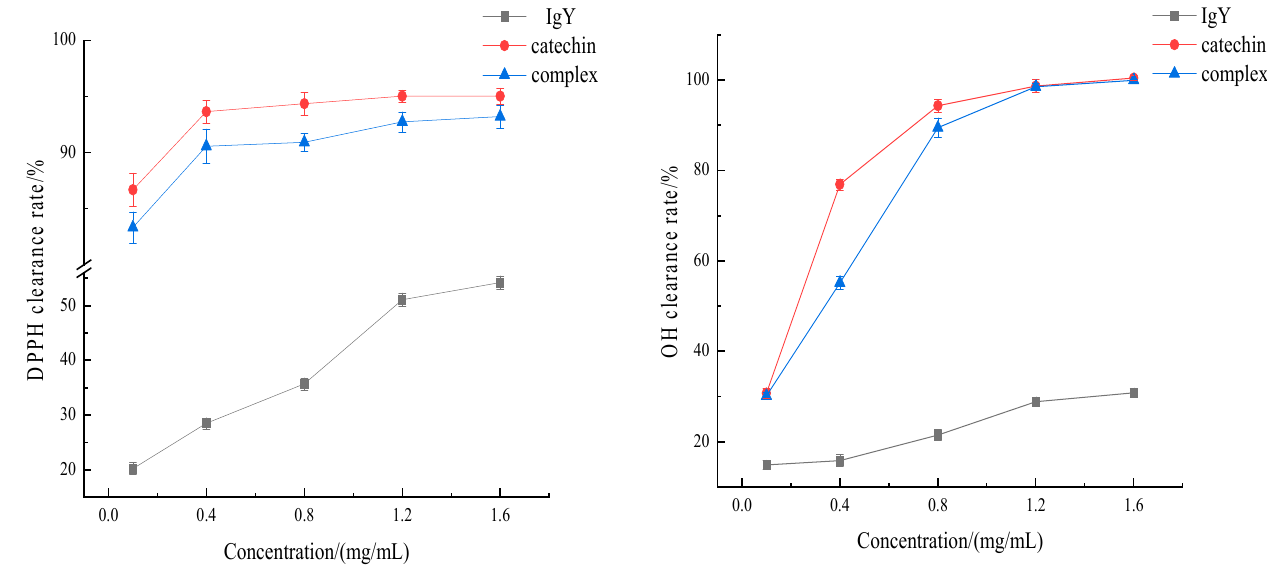
Figure 7. Effect of IgY interactions with catechins on antioxidation properties.